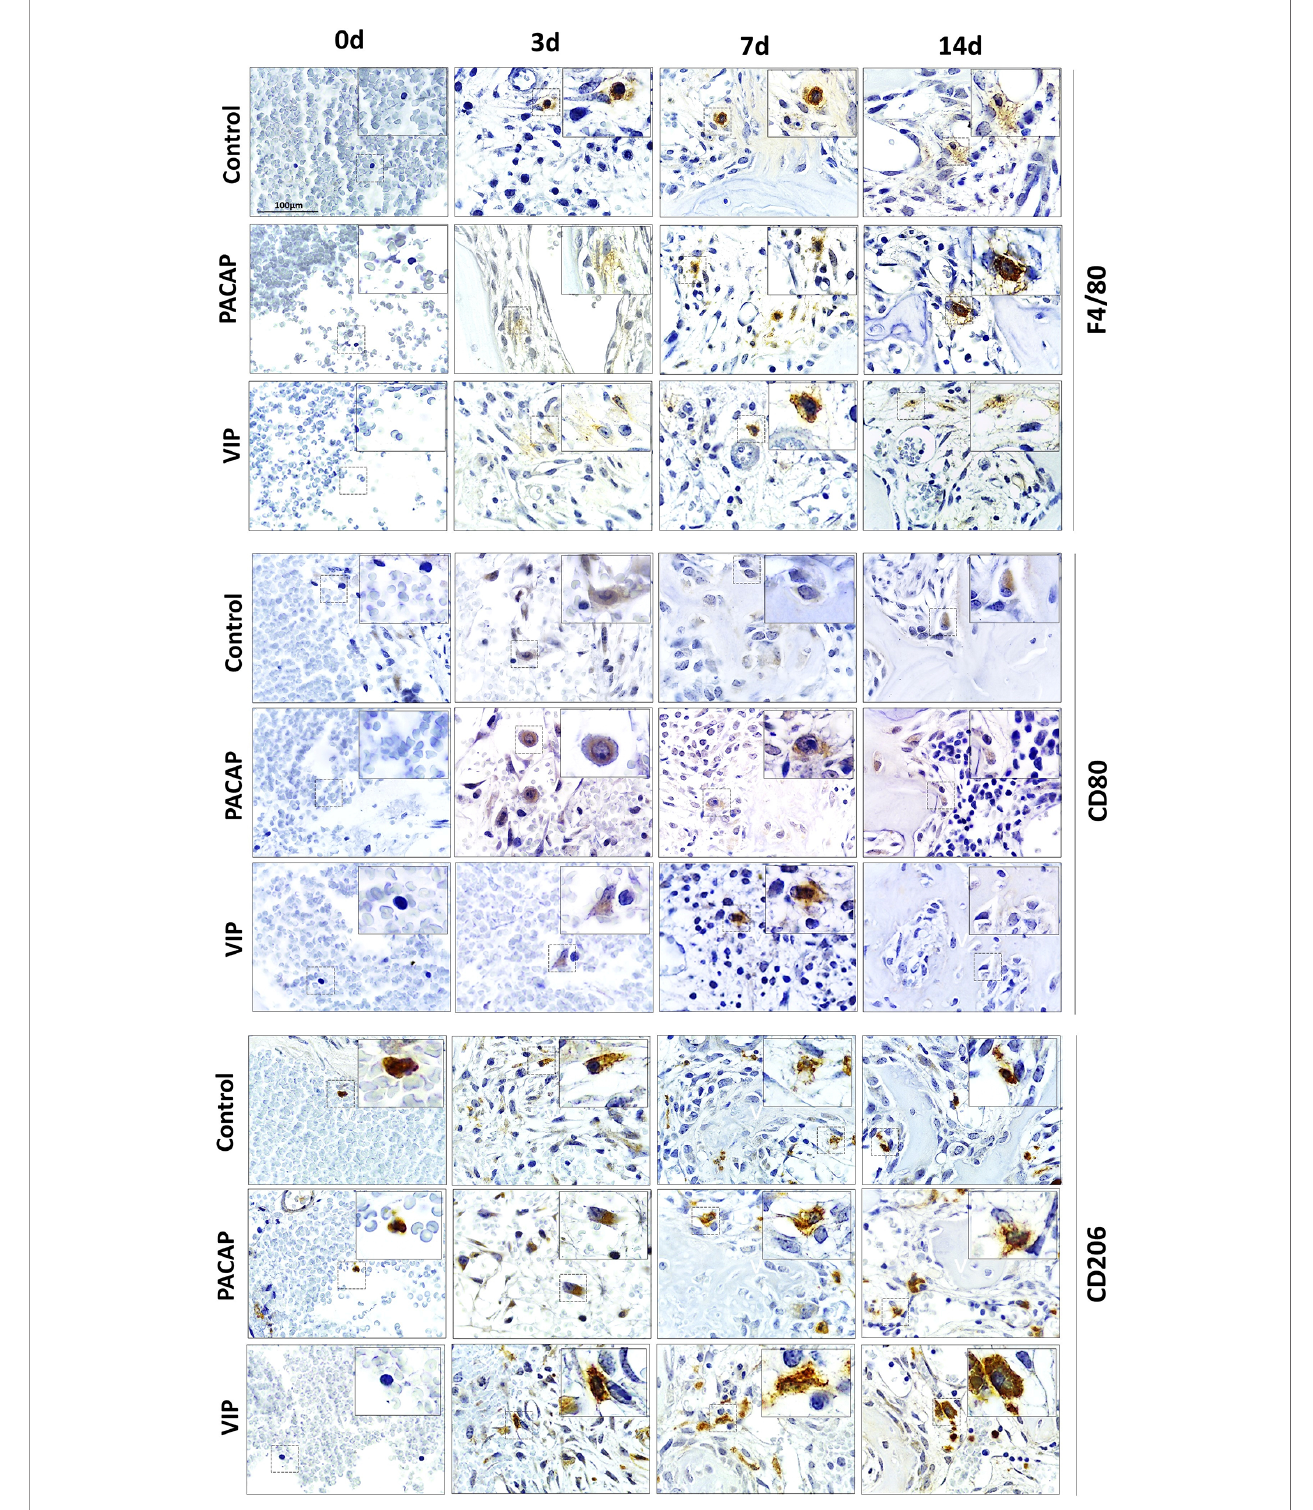
FIGURE 2 | Immunohistochemistry analysis for F4/80 + , CD80 + , and CD206 + cells present in the bone repair process in control, VIP and PACAP treated groups. Representative sections from medial thirds of the socket at days 0, 3, 7 and 14 days after tooth extraction. Anti-staining Mayer ’ s hematoxylin; objective of 100×.